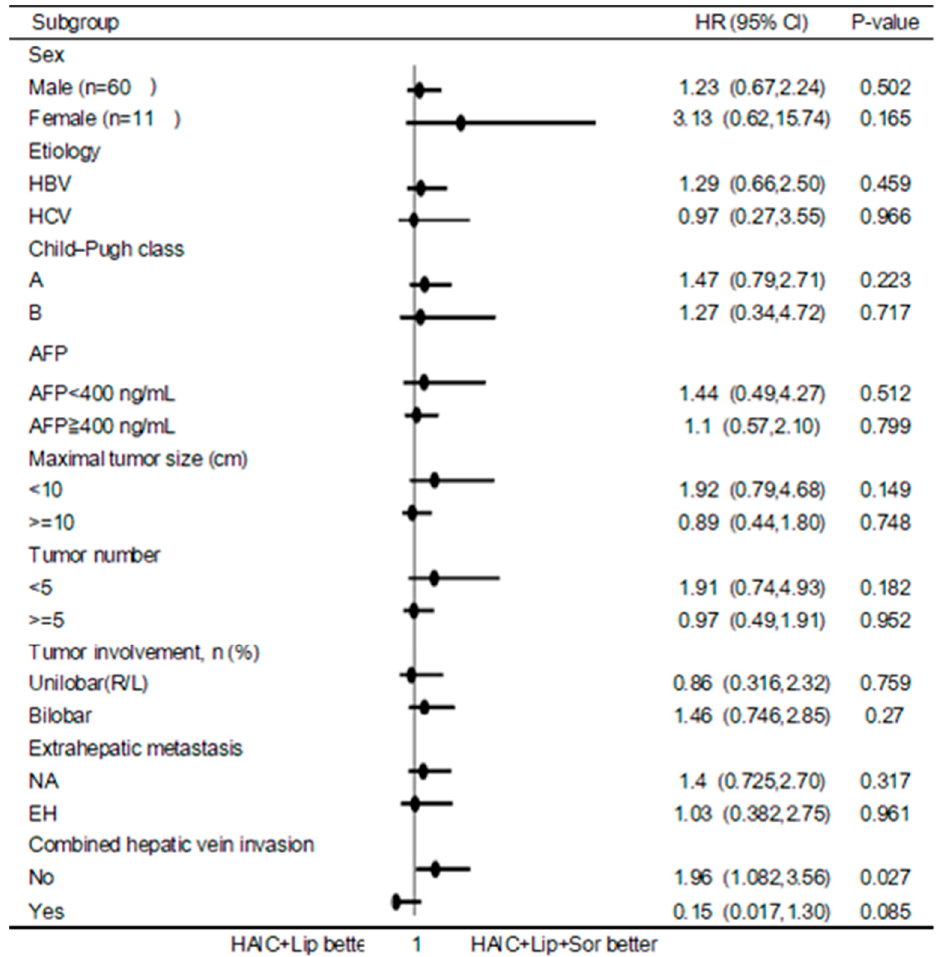
Figure 5. Forest plot of the treatment effect on OS in the subgroup analysis. Horizontal lines represent 95% confidence interval. The position of the circle represents the point estimate of the treatment effect.